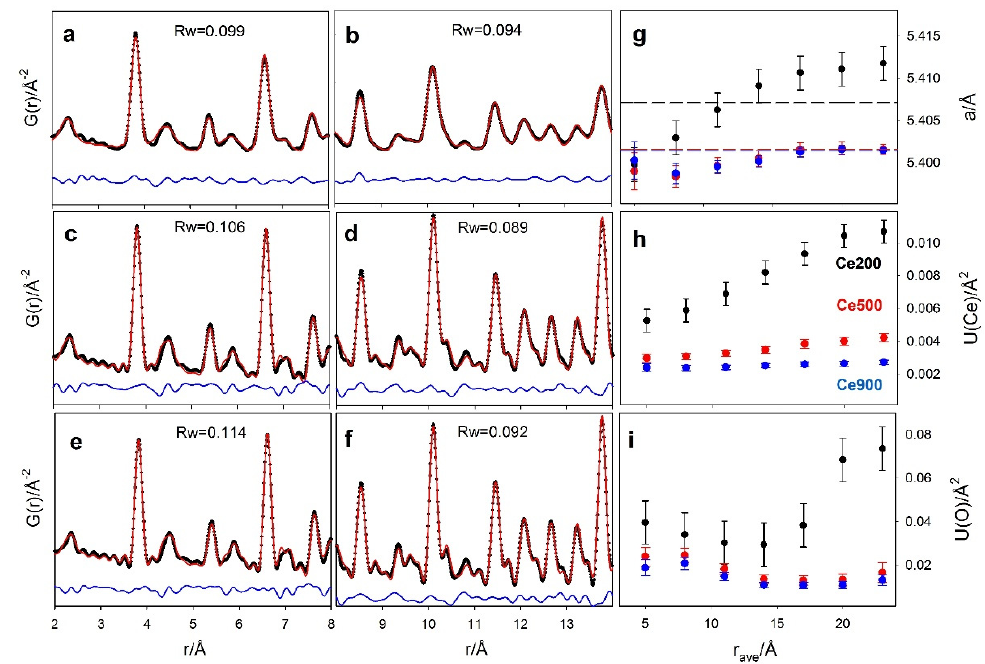
Figure 5. Real-space Rietveld refinements of G( r ) collected on Ce200 ( a , b ); Ce500 ( c , d ); Ce900 ( e , f ) in two different r ranges (2–8 Å and 8–14 Å). Experimental data, best fit and residuals are black crosses and red and blue solid lines, respectively. R w values are also reported in each panel. Selected refined parameters of the real-space refinements are reported in panels ( g ) (cell constants a) ( h , i ) (Ce and O displacement parameters) as a function of the centroid of the r range of the box-car refinements. Refined parameters from measurements on the Ce200, Ce500 and Ce900 samples are reported as black, red and blue circles, respectively.